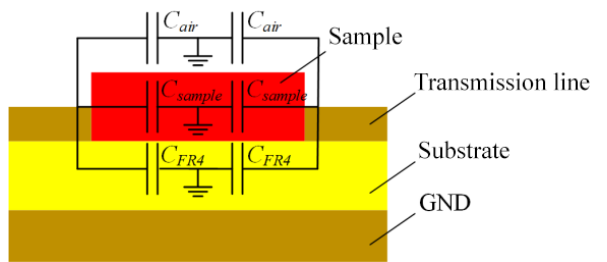
Figure 6. Cross section of the split